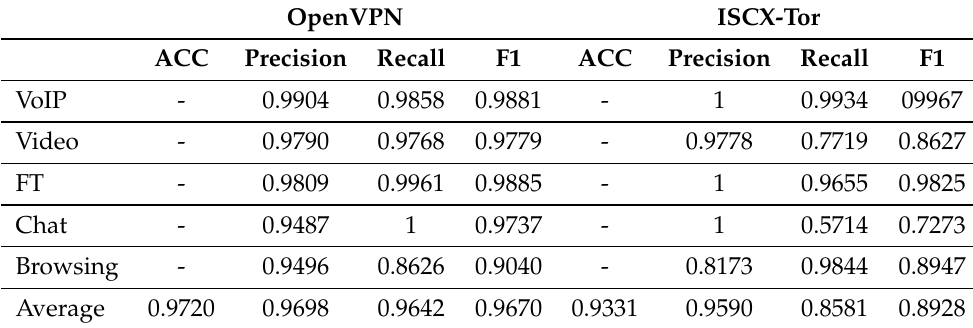
Table 6. Results in OpenVPN and